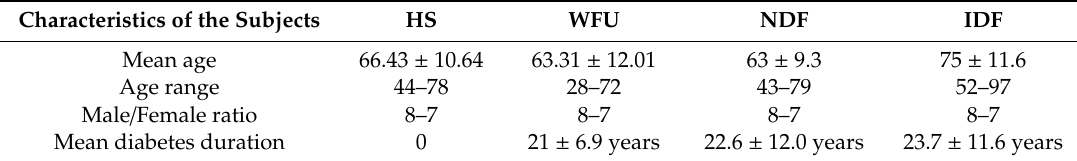
Table 1. Baseline characteristics of the subjects enrolled in the